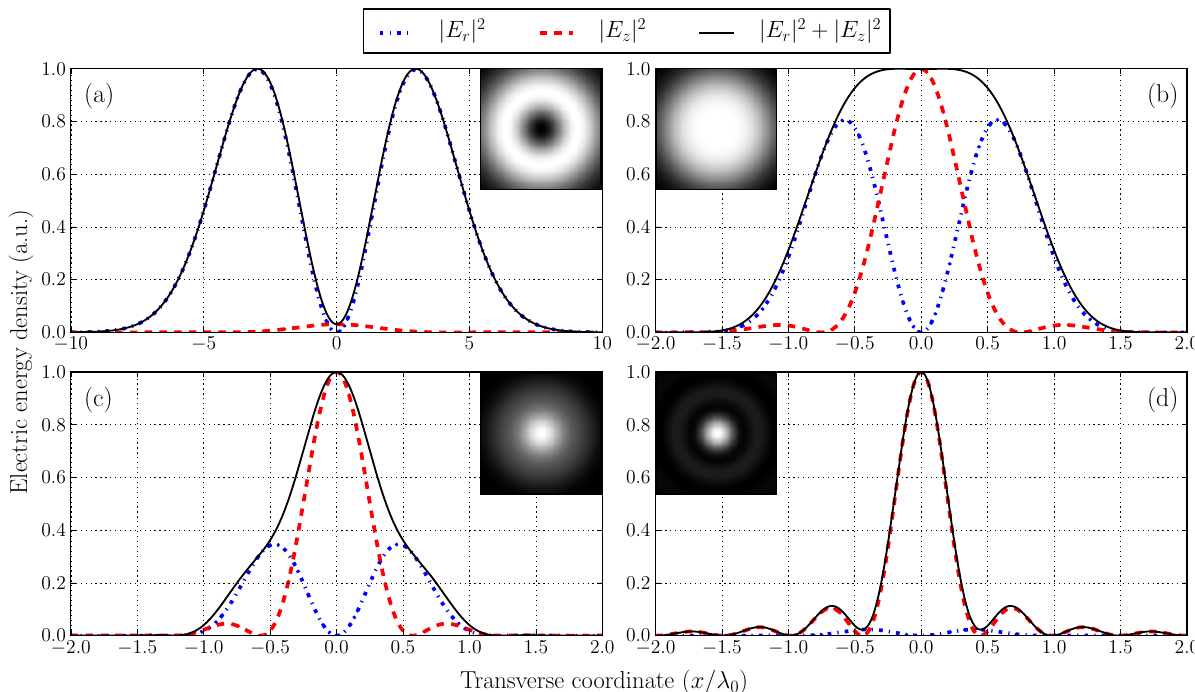
Figure 1. Transverse distribution of the average electric energy density W a focused RPLB at beam waist. The energy density associated with the individual electric field components is shown to emphasize the contribution of the longitudinal field when the beam spot size is comparable to or below the wavelength. In ( a ) k ( c ) k z z = 5 ; and ( d ) k = 1 . Insets show the intensity distribution (the scale is that of the 0 0 0 0 corresponding transverse coordinate